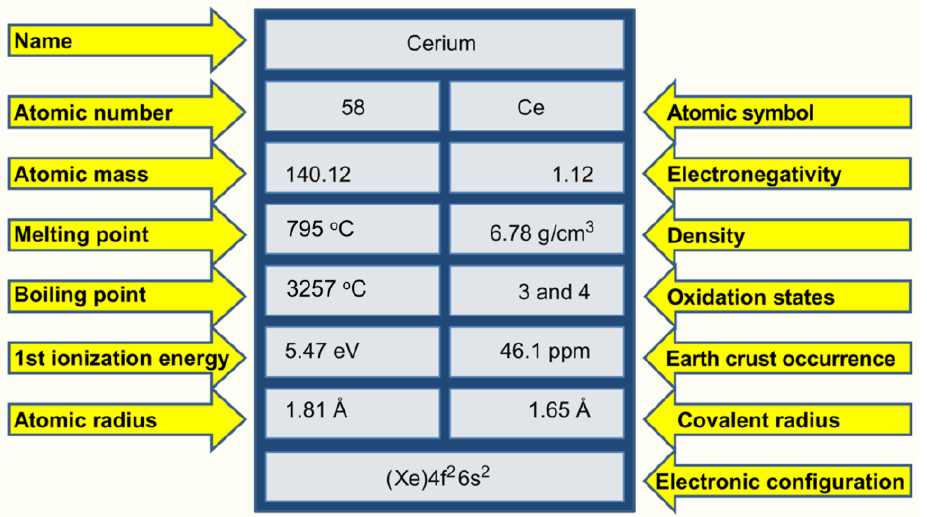
Figure 2. The main properties of elemental Ce. Reproduced with permission from Ref. [2]. Copyright© 2020, Elsevier.